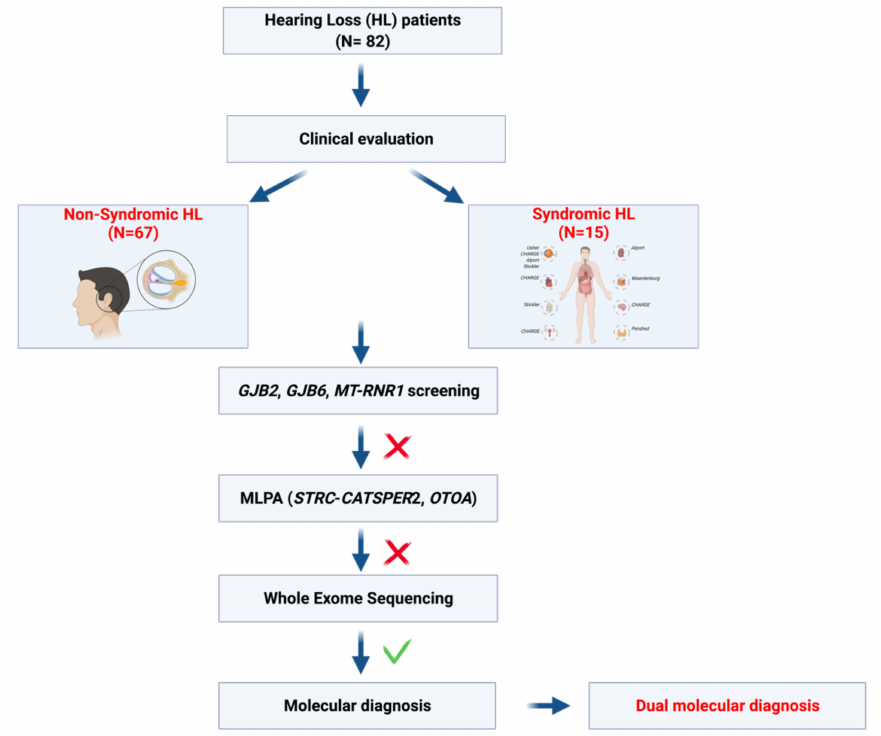
Figure 1. Schematic representation of the multi-step approach applied in the present study. During the last year, a total of 82 patients displaying HL have been enrolled. All of the patients underwent a careful clinical evaluation to distinguish between non-syndromic HL and syndromic HL. Afterward, individuals were screened for mutation in GJB2 , GJB6 , and MT-RNR1 genes and for deletions in STRC-CATSPER2 and OTOA genes. Subsequently, whole-exome sequencing has been applied, allowing the identification of a series of dual molecular